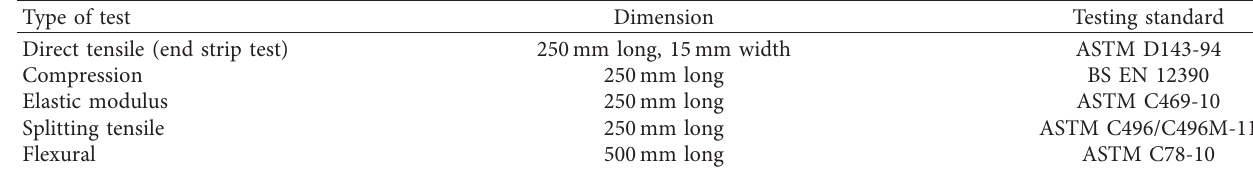
Table 1: Dimension of prepared specimens for each